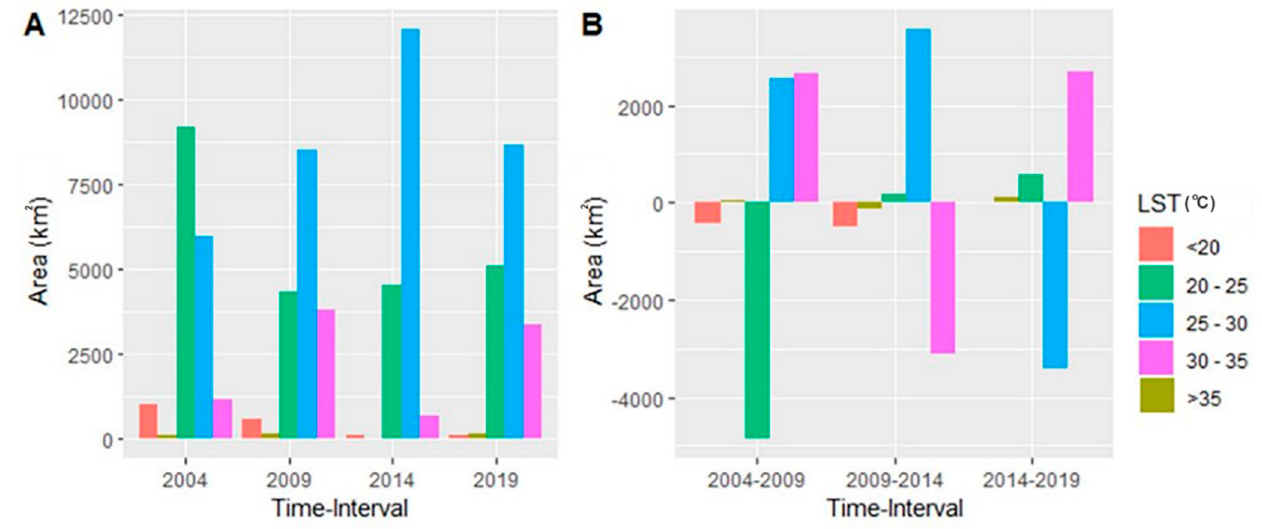
Figure 6. Details of the land surface temperature (LST), ( A ) the bar plots represent the relative proportion (Km 2 ) of various